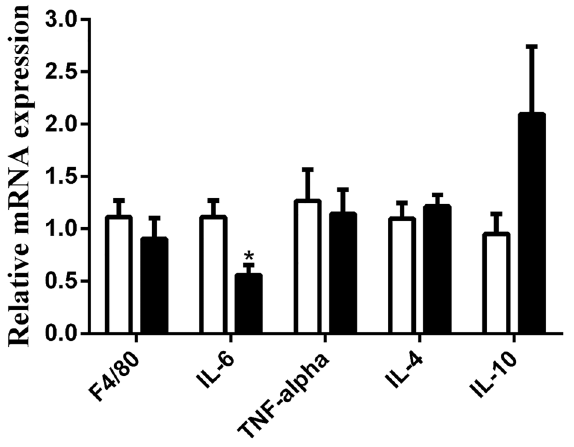
Figure 8. mRNA expression in gastrocnemius muscle of mice fed with either high-carbohydrate diet (HCD group, white bars) or high- fat diet (HFD group, black bars) for 2 months. b 2-microglobulin ( b 2m) was used as the housekeeping gene. Results are reported as means ± SE (n=8 – 10). *P o 0.05 compared to the HCD group (Student ’ s t -test). TNF- a : tumor necrosis factor alpha; IL: